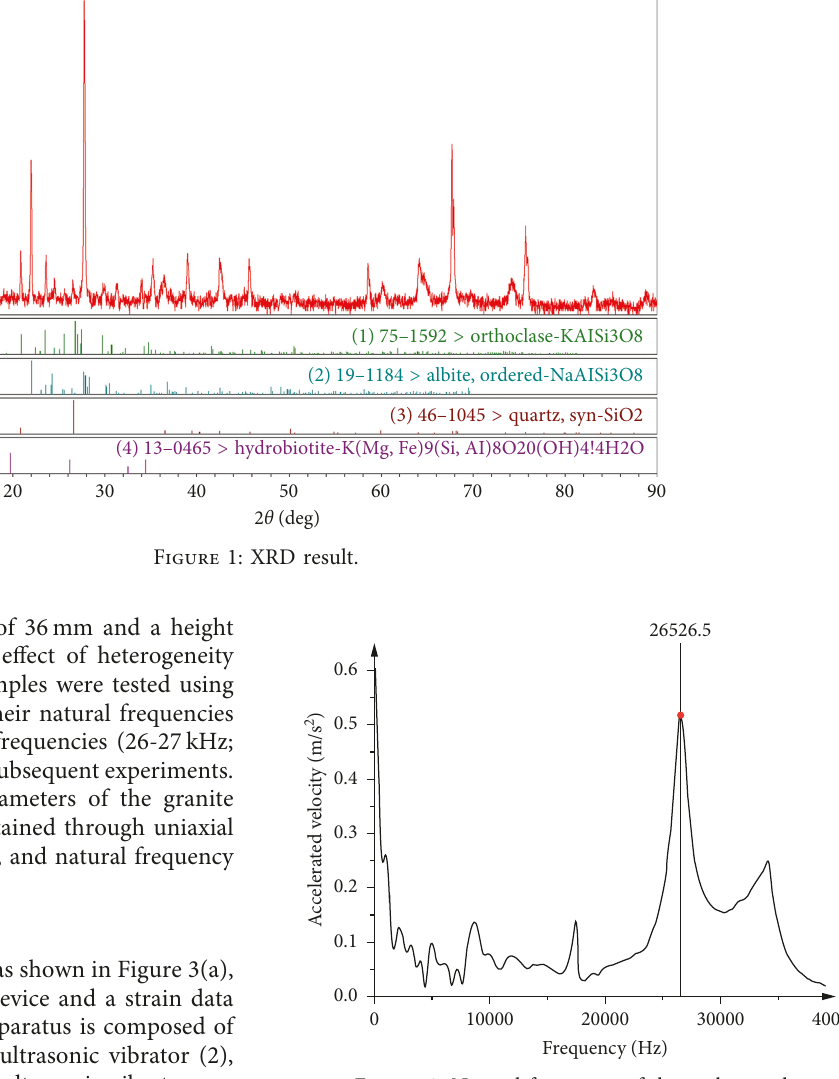
Figure 2: Natural frequency of the rock sample. Table 2: Mechanical properties of the granite